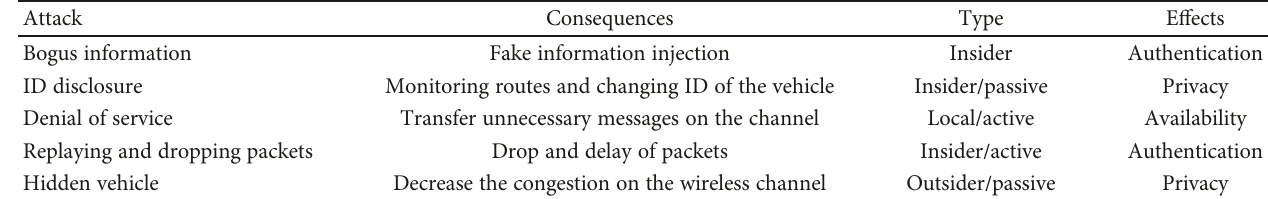
Table 1: Attacks and their